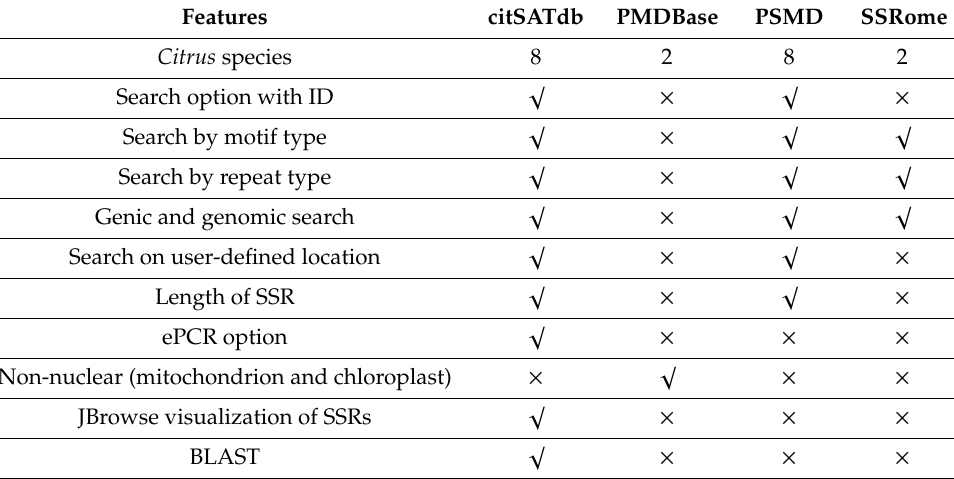
Table 6. Comparison of citSATdb with PMDBase, PSMD, and SSRome